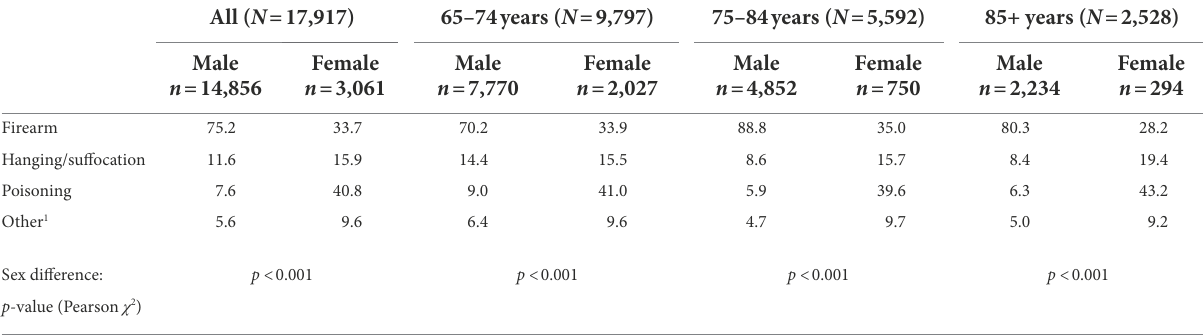
TABLE 2 Suicide means by age group and sex